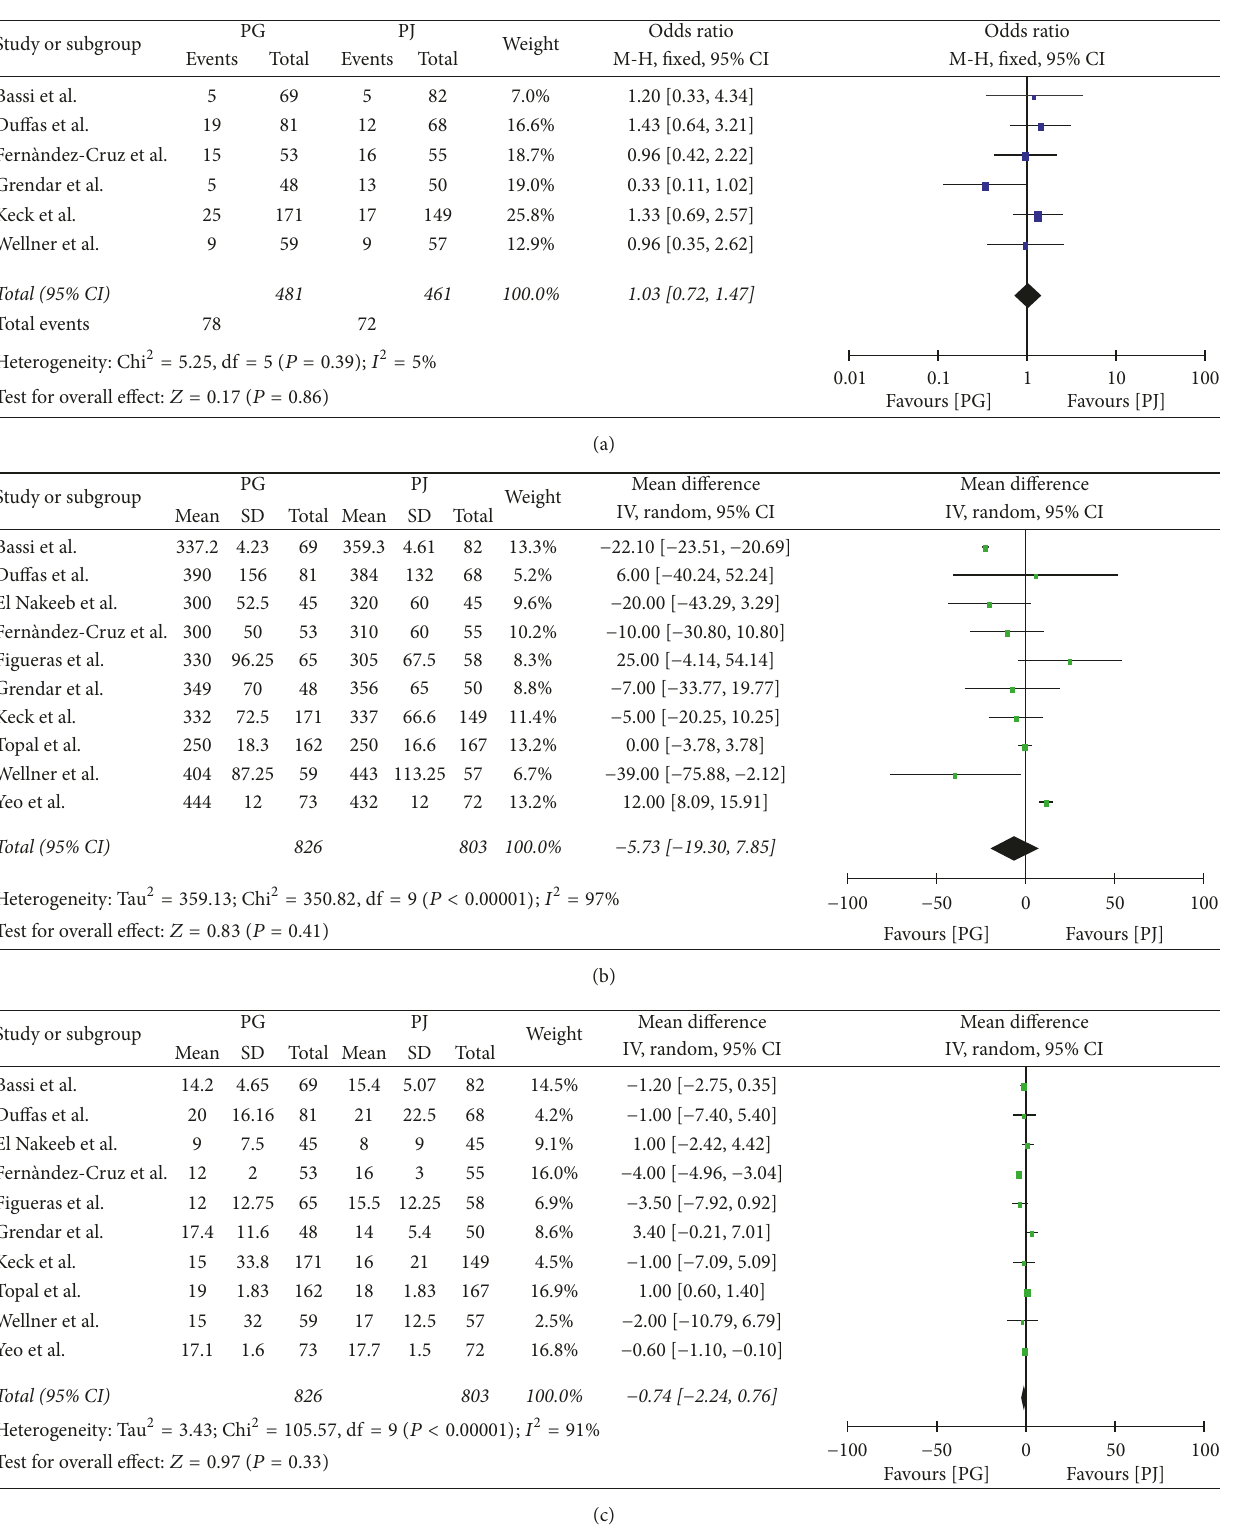
Figure 8: (a) Blood transfusion, (b) operative time, and (c) length of hospital